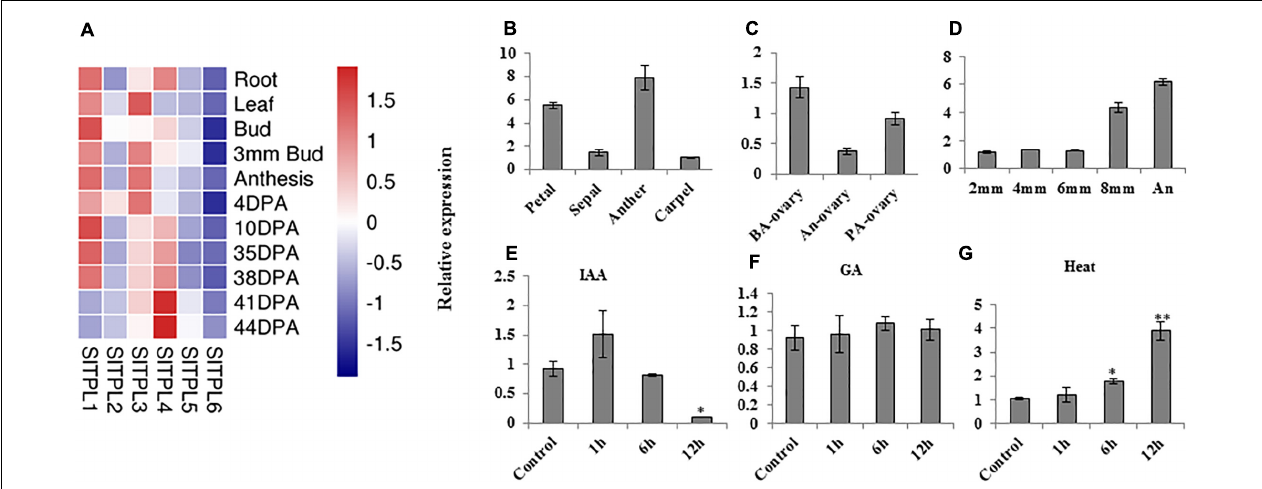
FIGURE 1 | Expression pattern analysis of SlTPL1 by qRT-PCR. (A) Heat map of expression levels of SlTPL s family genes in various tomato organs based on the RNA-seq data on the tomexpress website. (B–D) Expression pattern of SlTPL1 in tomato organs by qRT-PCR. (E–G) Expression pattern of SlTPL1 under auxin, GA, and heat treatment. T -test was used for statistical analyses of comparison between the control and each treatment, * P < 0.05, ** P < 0.01. BA-ovary: ovaries at 2 days before anthesis. An-ovary: ovaries at anthesis. PA-ovary: ovaries at 4 days post anthesis. 2 mm: anther from a 2-mm flower bud; 4 mm: anther from a 4-mm flower bud; 6 mm: anther from a 6-mm flower bud; 8 mm: anther from an 8-mm flower bud; An: anther of a flower at